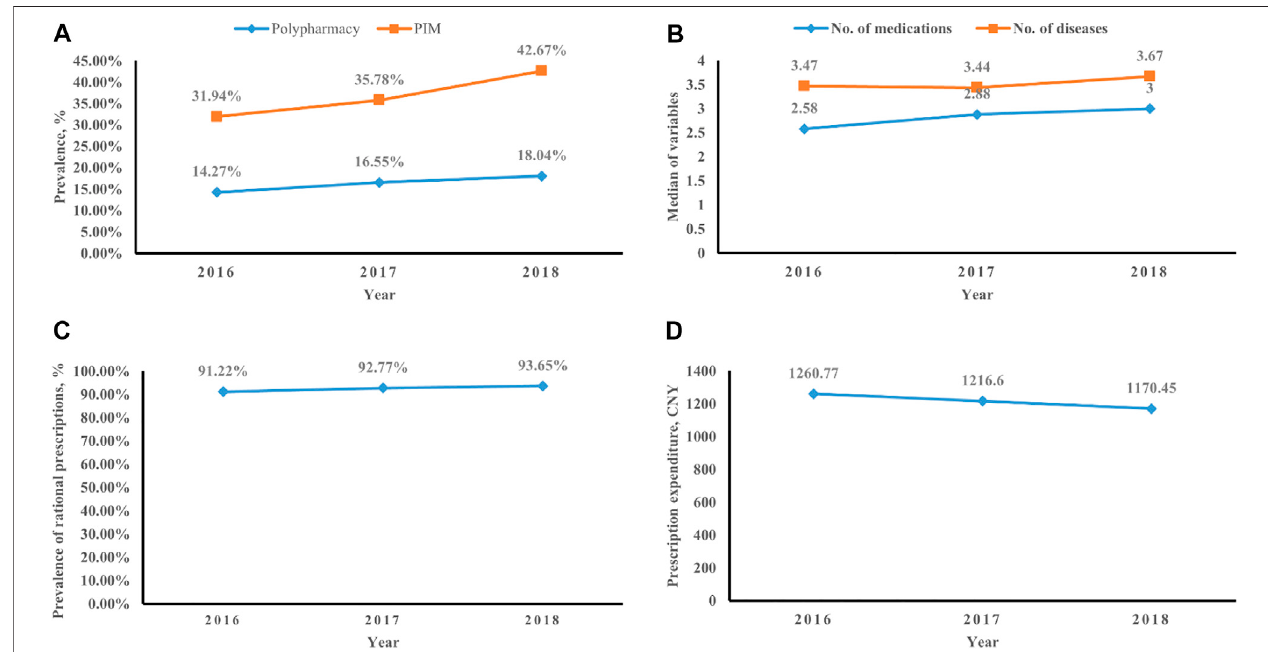
FIGURE 1 | Trends in older lung cancer outpatients with multimorbidity. (A) Prevalence of polypharmacy and PIM use. (B) Number of medications and diseases. (C) Rate of rational prescriptions. (D) Prescription expenditure.